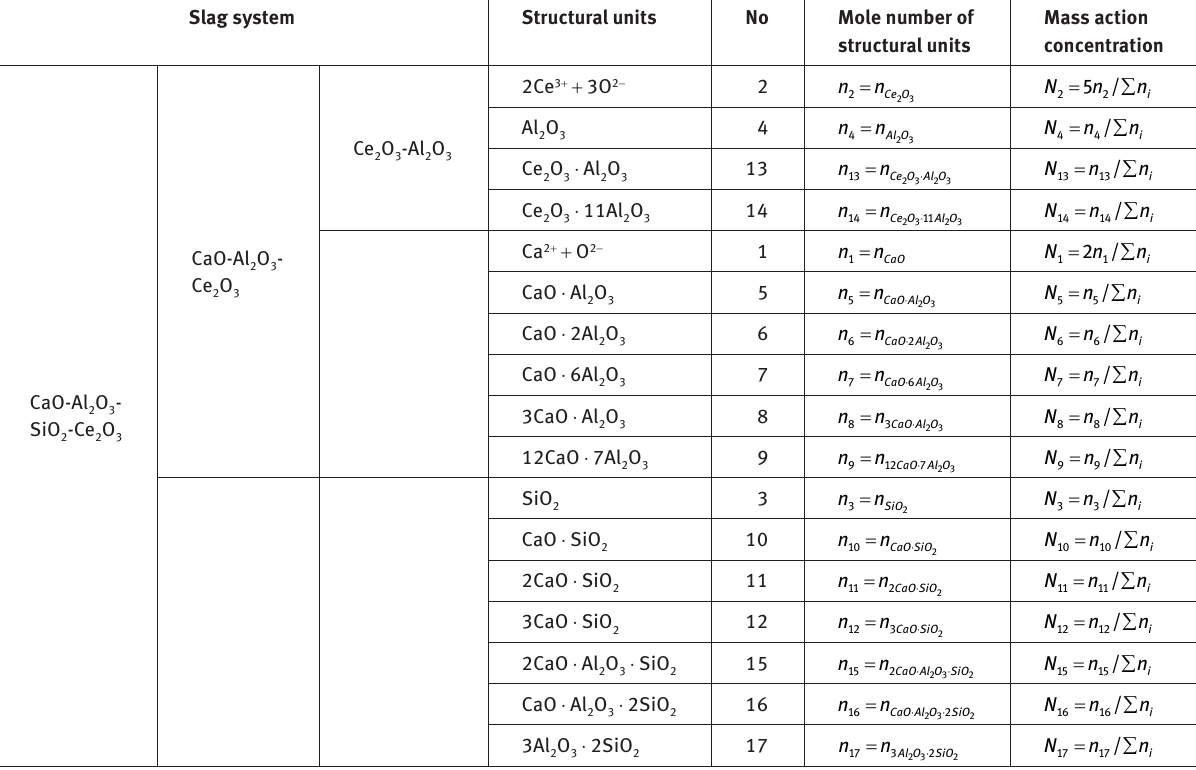
Table 1: Expression of structural units, their mole numbers and mass action concentrations of Ce 2 O 3 -Al 2 O 3 , CaO-Al 2 O 3 -Ce 2 O 3